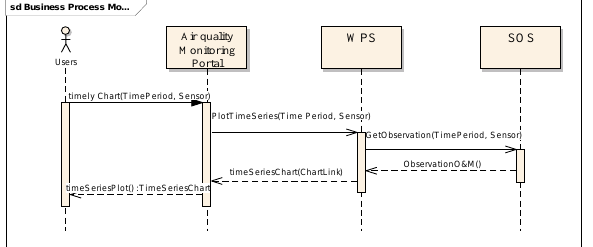
Figure 5-Create Time Series chart From